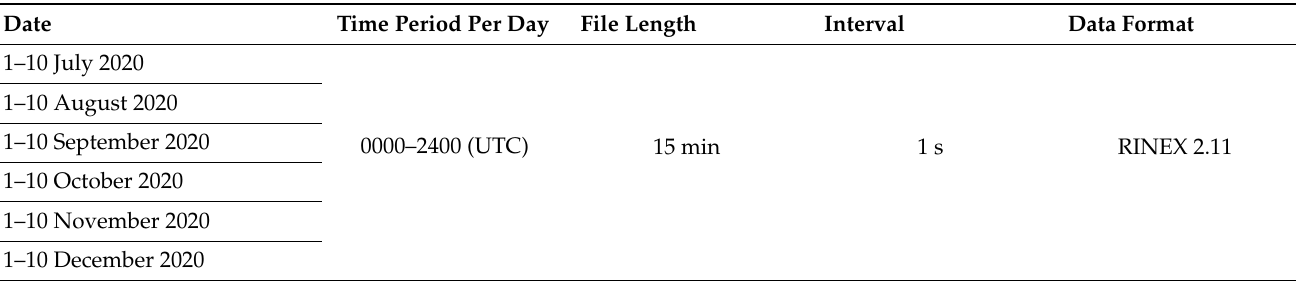
Table 6. Observation/data file information of the GPS data quality assessment of the selected IGS stations in